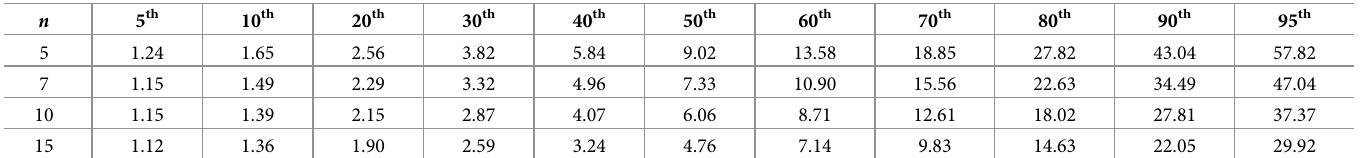
Table 6. Out-of-control expected percentiles of the run length distribution for the EARL -based side sensitive synthetic- γ chart for γ 0 = 0.05, n 2 {5,7,10,15} and ( τ min , τ max ) =